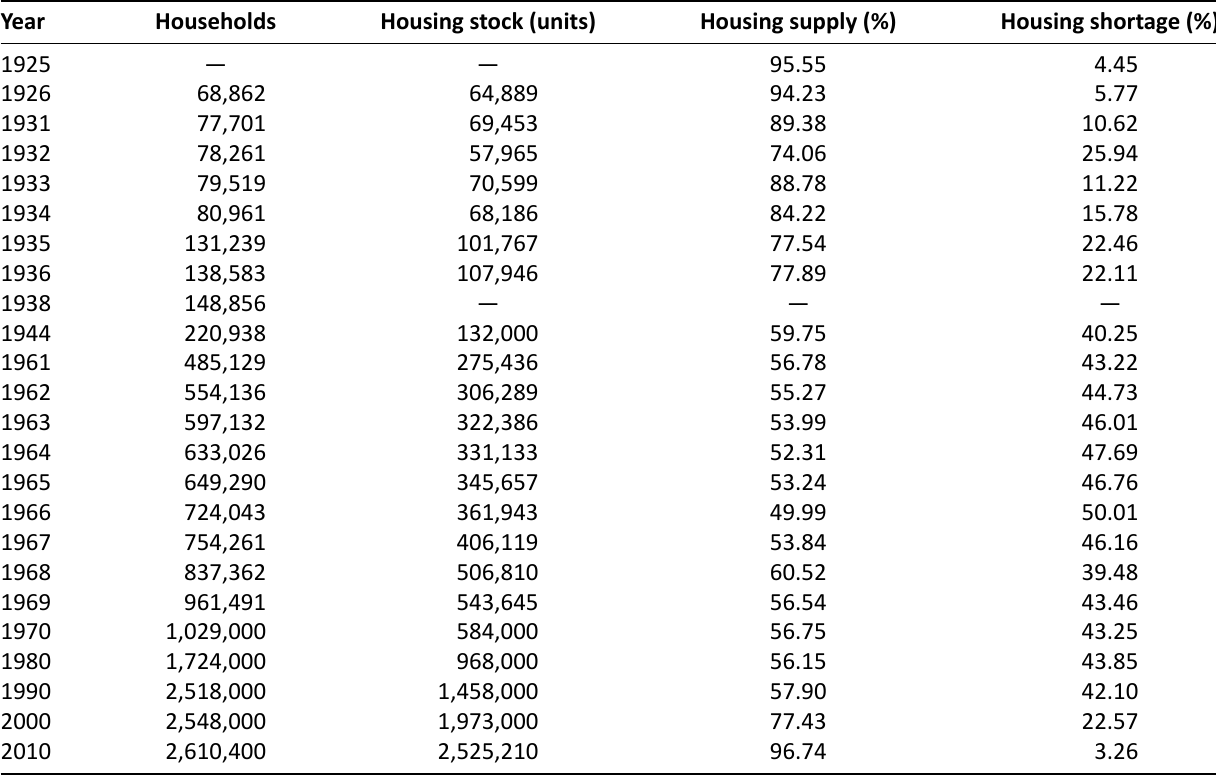
Table 1. Housing shortages (Seoul) in the Japanese colonial period. Data extracted from Kim (2010) and Son (1996b).